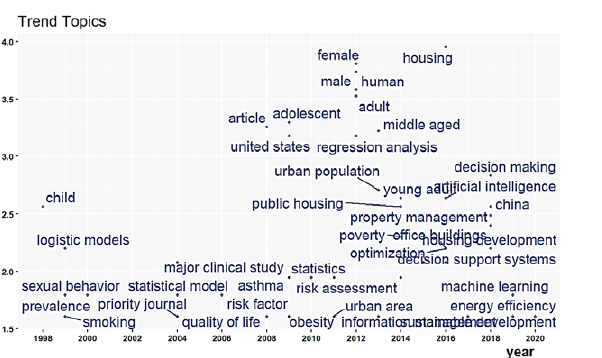
Figure 3. Occurrence of keywords in AI and PM research work